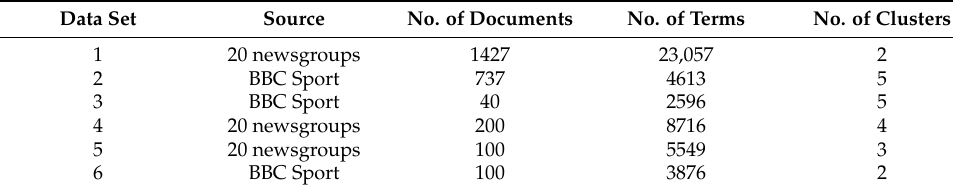
Table 3. Benchmark data